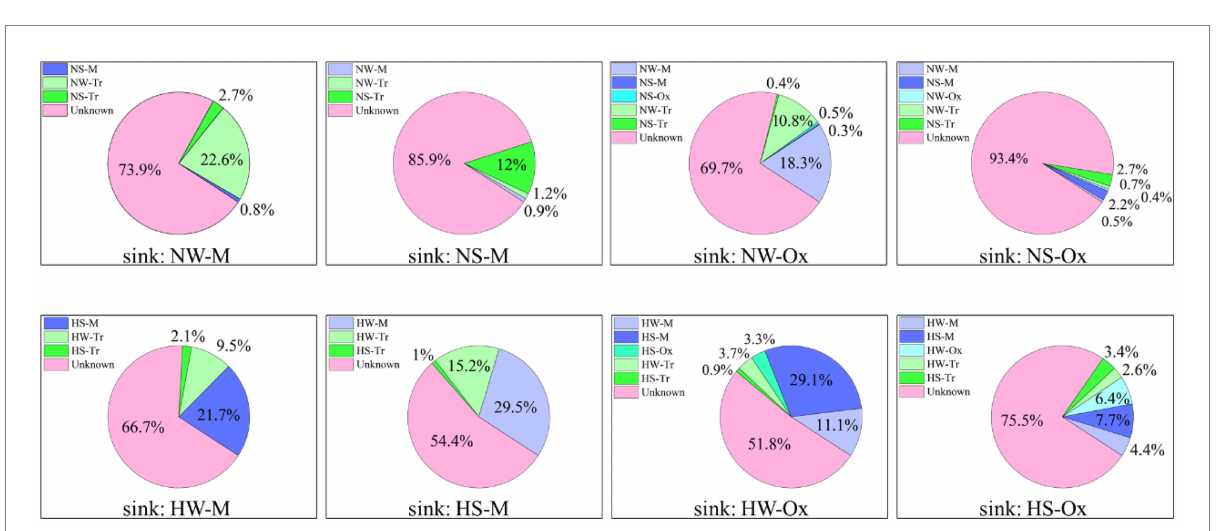
FIGURE 6 SourceTracker estimates of the contributions of source communities to sink communities of planktonic and sedimentary bacteria in the mainstream and oxbow lakes of Baihe River across different periods. NW, water in the normal period; NS, sediment in the normal period; HW, water in the high-water period; HS, sediment in the high-water period; M, mainstream; Tr, tributaries; Ox, oxbow